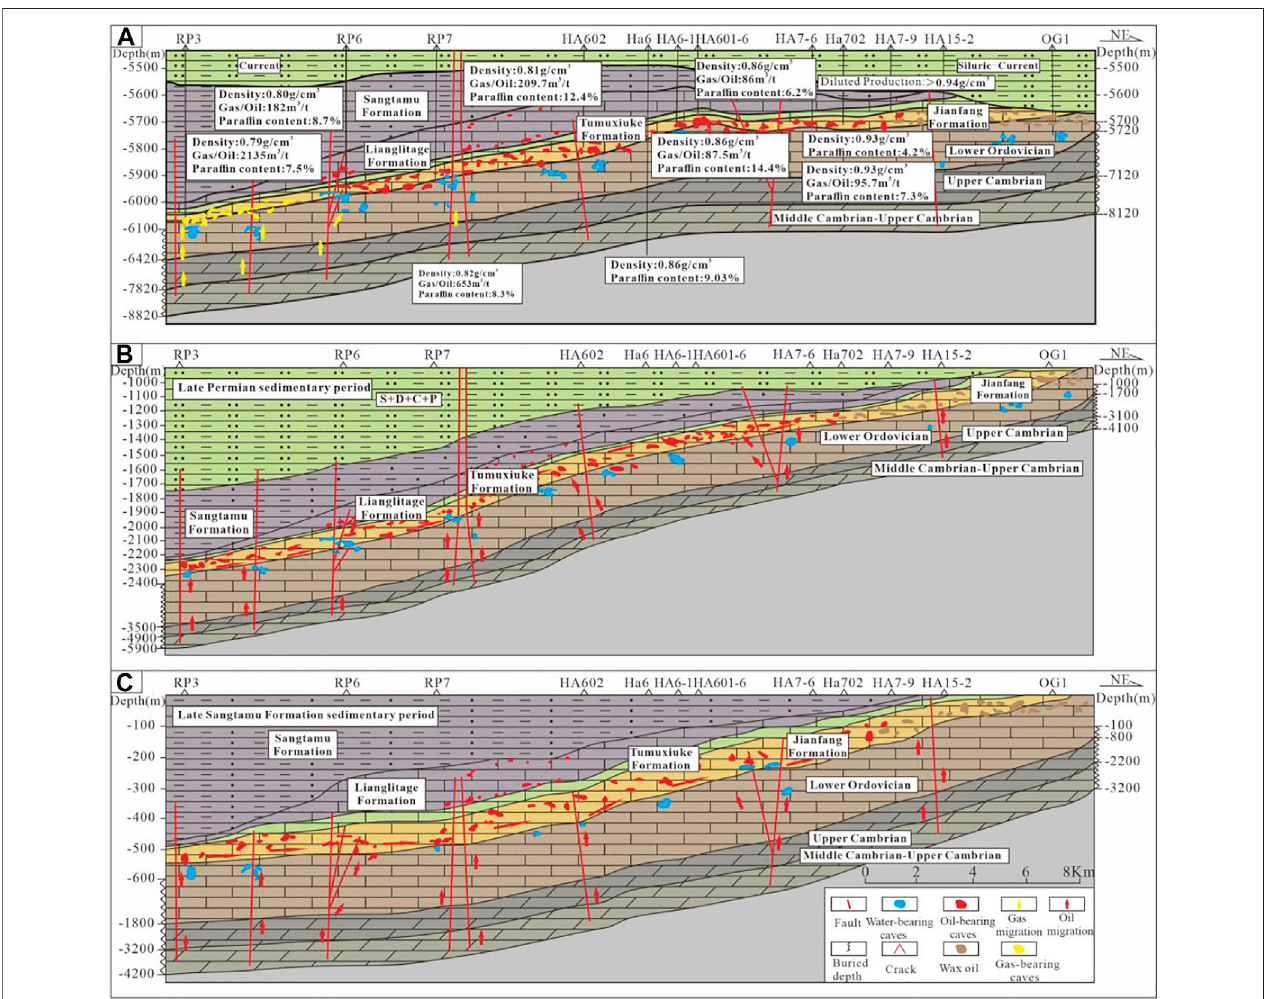
FIGURE 17 | Hydrocarbon accumulation model of Ordovician in the Halahatang Area, and Tarim Basin.